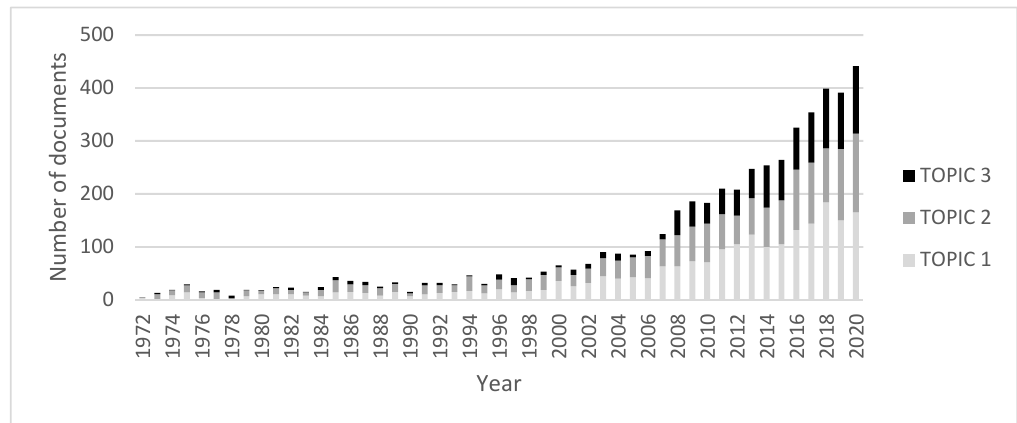
Figure 1. Total documents retrieved per year [5] from topics 1, 2, and 3: TOPIC 1 “Calcite” or “Aragonite” or “Calcium carbonate” or “scale” and “Water” and “Hardness”; TOPIC 2: “Water treatment” or “Scale prevention” or “Chemical softening” or “Chemical precipitation inhibitors” or “Membrane treatment” or “Cation exchange resins” or “Electrochemical treatments” and “Water” and “Hardness”; TOPIC 3: “Magnetic field” or “Electromagnetic field” and “Water treatment” (own elaboration).